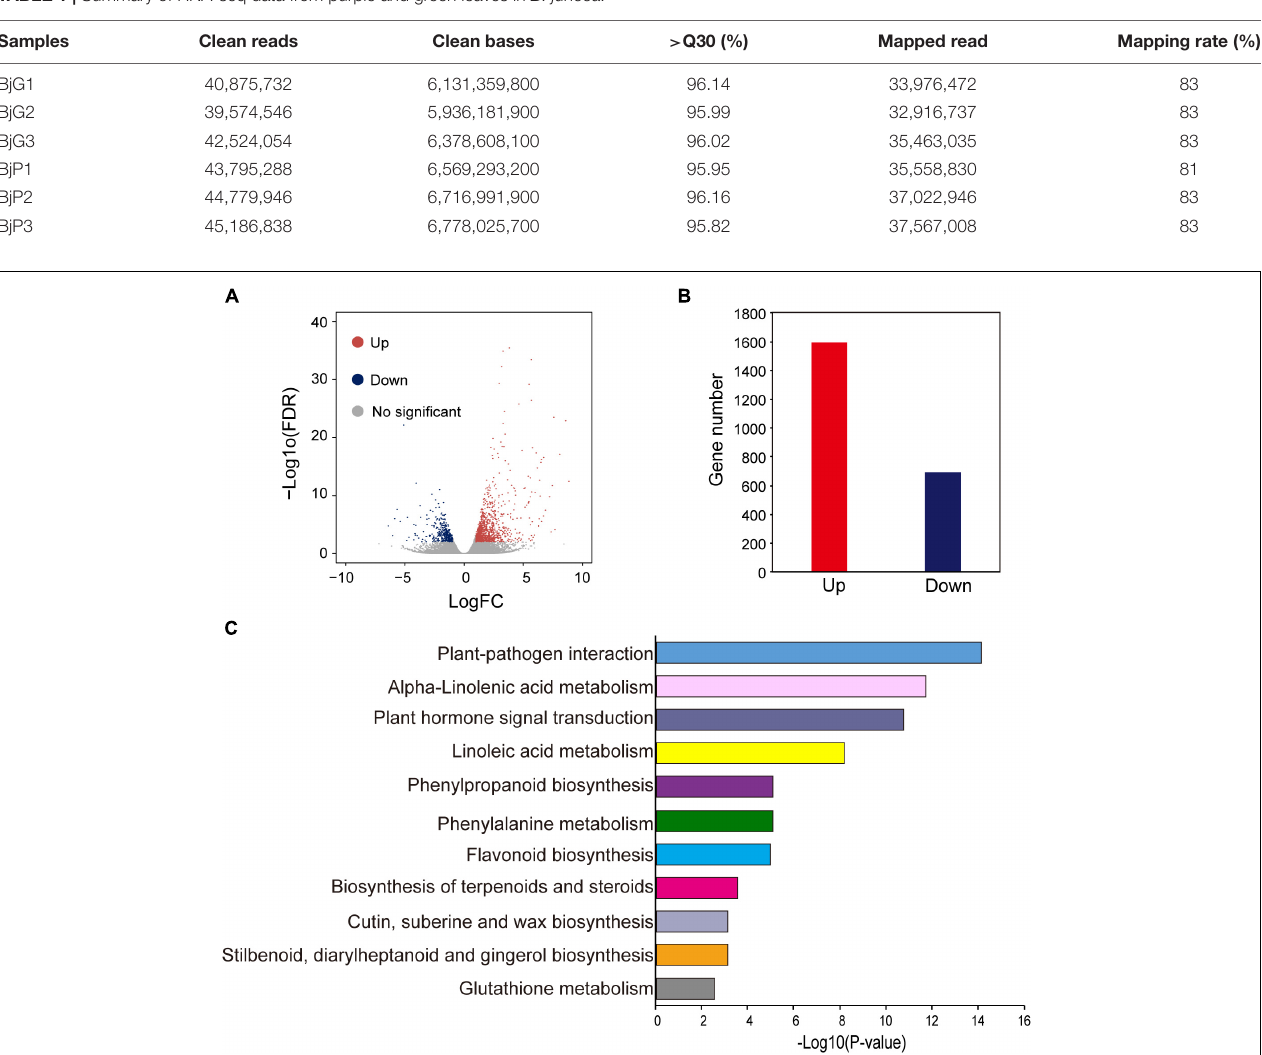
FIGURE 2 | Different expressed genes between purple and green leaf. (A) The volcano map of DEGs between ZiYi and LvYi. Each dot represents a gene. (B) The number of up- and down-regulated genes in ZiYi. (C) KEGG metabolism pathway analysis of the DEGs between ZiYi and LvYi. Histograms represent the metabolism pathway distribution; the X axial represents the number of genes that have been annotated to the metabolism pathway.